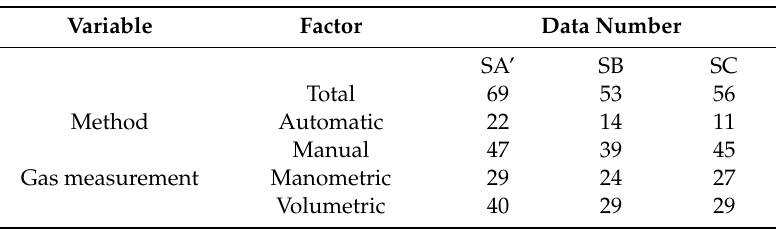
Table 9. ANOVA with 4 factors for SA’, SB and